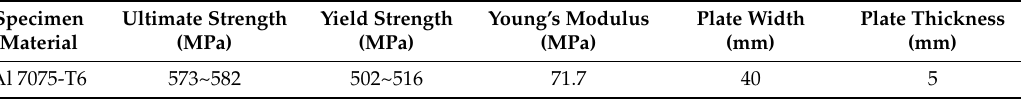
Table 1. Material and geometry properties of plate specimens.